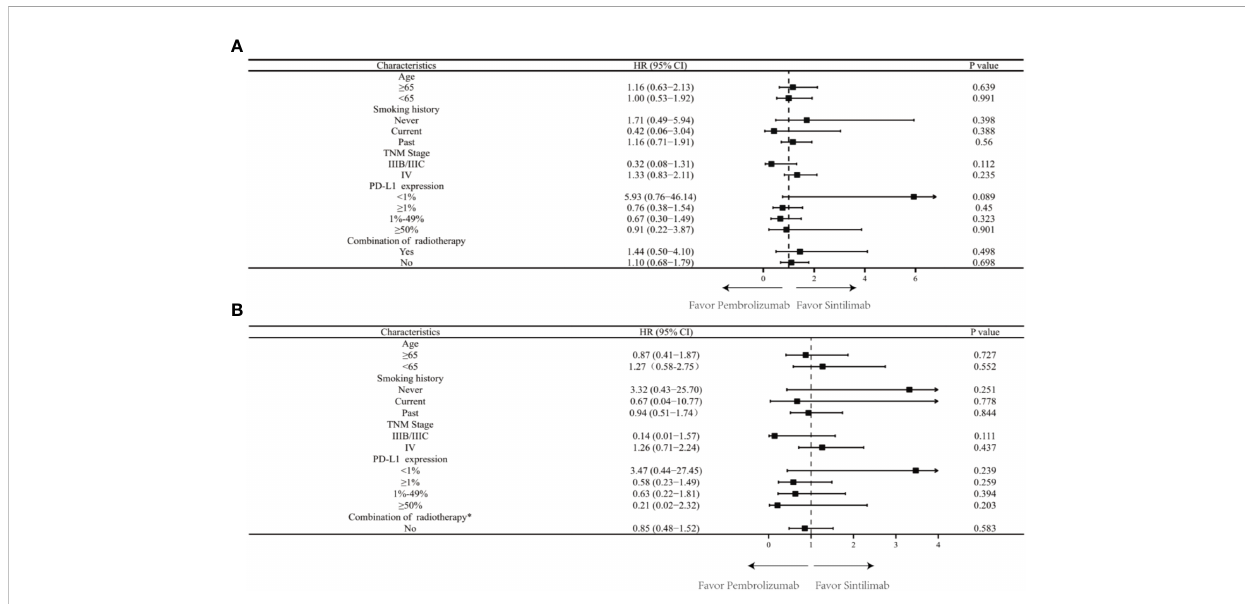
FIGURE 2 (A) Progression-free survival by subgroup in the full analysis set. TMN, tumor, node, metastasis; PD-L1, programmed death-ligand 1; HR, hazard ratios; CI, con fi dence interval; (B) Overall survival by subgroup in the full analysis set. TMN, tumor, node, metastasis; PD-L1, programmed death- ligand 1; HR, hazard ratios; CI, con fi dence interval.*Data not presented for subgroups of “ Yes in Combination of radiotherapy ” owing to very few patients which precludes any meaningful